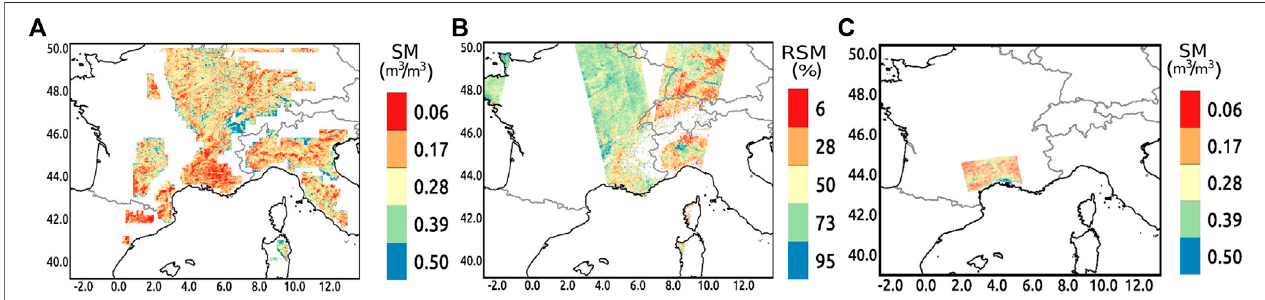
FIGURE 7 | SM images at 1 km resolution from DISPATCH veg – ext (A) , Copernicus Sentinel-1 (B) , SMAP/S1 (C) on DOY 204, 2018.